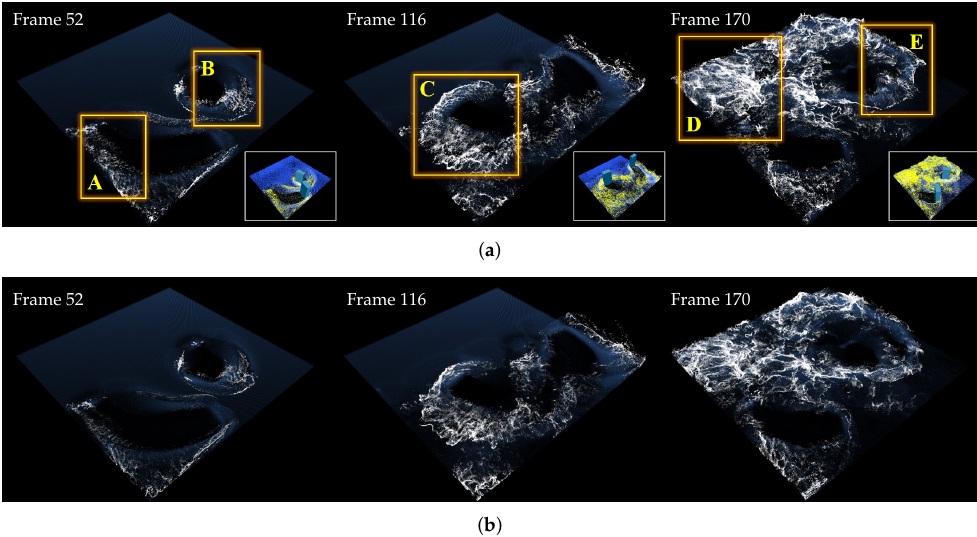
Figure 12. Rotating two boxes in water simulation. The related video has been submitted as Supple- mentary Material. ( a ) Our method (inset image: simulation view). ( b ) Kim and Lee